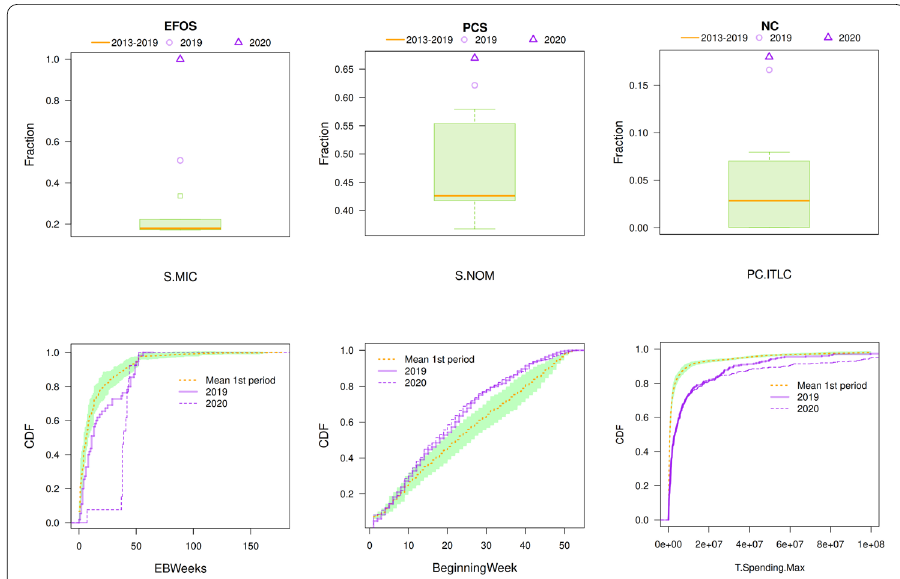
Figure 3 Example variables illustrating the main differences between both government periods. Left: Differences between contracts in the EFOS class. TopLeft: Fraction of “micro companies” ( S.MIC ) for the contracts in the EFOS class. In green, boxplot of the 6 years comprising the 1st government period. Bottom Left: Cumulative distribution function (CDF) for the number of weeks that the contract lasted ( EBWeeks ). The green area represents the CI at 99% generated by the data of the 1st period. Center: Differences between contracts in the PCS class. TopCenter: Fraction of contracts in the PCS class with “large” companies ( S.NOM ). BottomCenter: CDF for week that the contract began ( BeginningWeek ). Right: Differences between contracts in the NC class. TopRight: Fraction of contracts following the NAFTA procedures ( PC.ITLC ) in the NC class. BottomRight: CDF for the maximum spending made by a buyer with a single supplier ( T.Spending.Max ). In all graphs, the orange line corresponds to the mean of the 1st government period, and the two purple colored curves correspond to the first two years of the second government